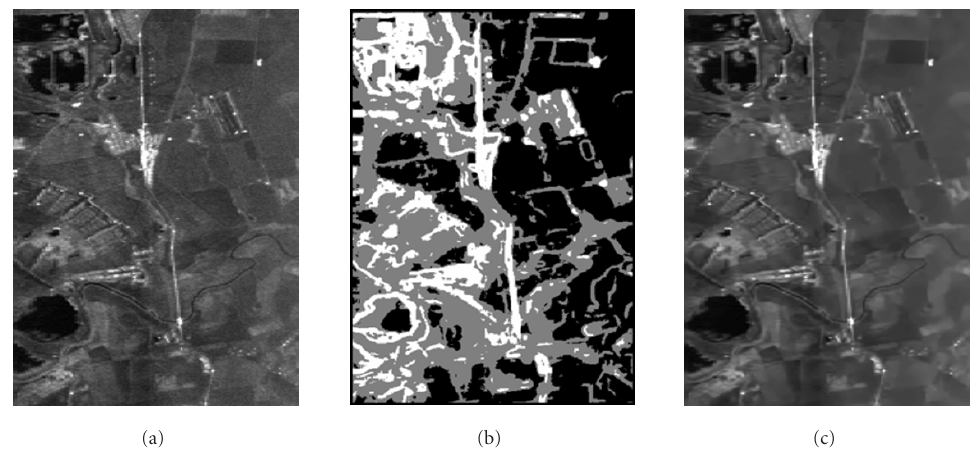
Figure 11: Visual example of the K a -band SLAR image processing ( σ 2 µ ≈ 0 . 005): (a) the original image, (b) the PC map obtained by CPC2, and (c) the output of the proposed three-state LAF.